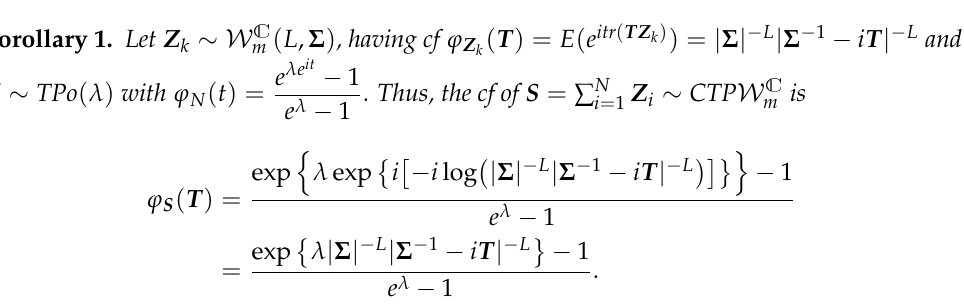
Figure 2. Marginal densities CTP W C m and CG W C m